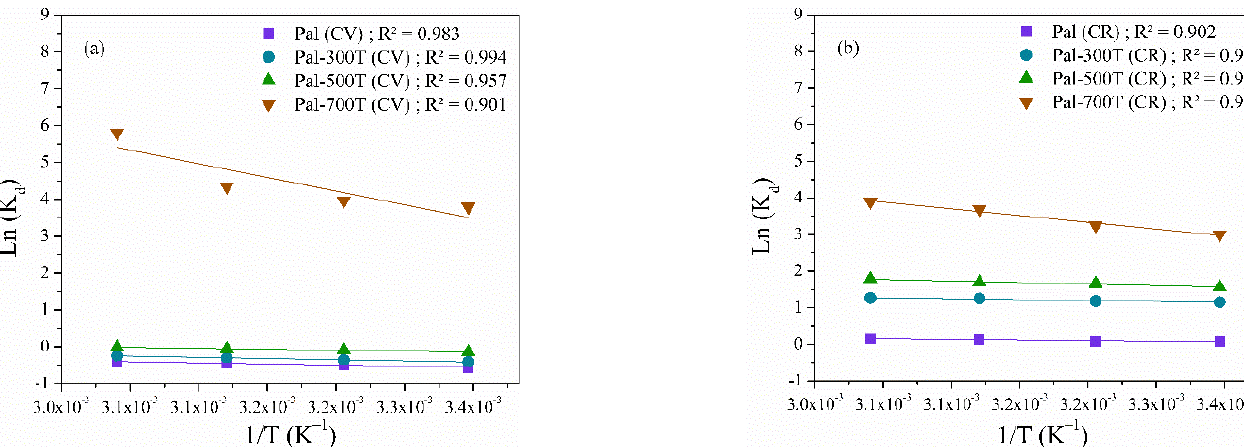
where K d is the distribution coefficient for adsorption and ∆ H, ∆ S and ∆ G are the enthalpy, entropy, and Gibb’s energy variations, respectively. The ∆ H and ∆ S values were calculated from the slope and intercept of the Ln Kd versus 1/T graph (Figure 8a,b). The values of ∆ H, ∆ S and ∆ G are listed in Table 5. The positive ples is an endothermic process [107]. In addition, positive ΔS values indicated greater ran- endothermic process [107]. In addition, positive ∆ S values indicated greater randomness domness at the solid-liquid interface [108] and negative ΔG values confirmed the sponta- at the solid-liquid interface [108] and negative ∆ G values confirmed the spontaneity and viability of adsorption in the entire temperature range studied [31].